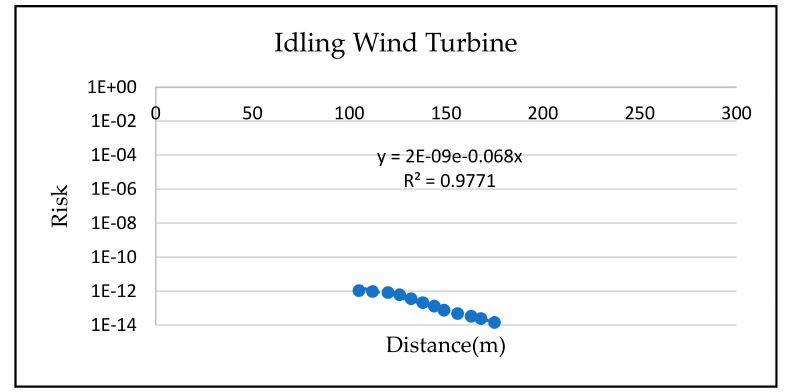
Figure 3. The risk R A , TO per year per kilometer due to icing events as a function of distance to the road for wind turbines in parked position, from [25].